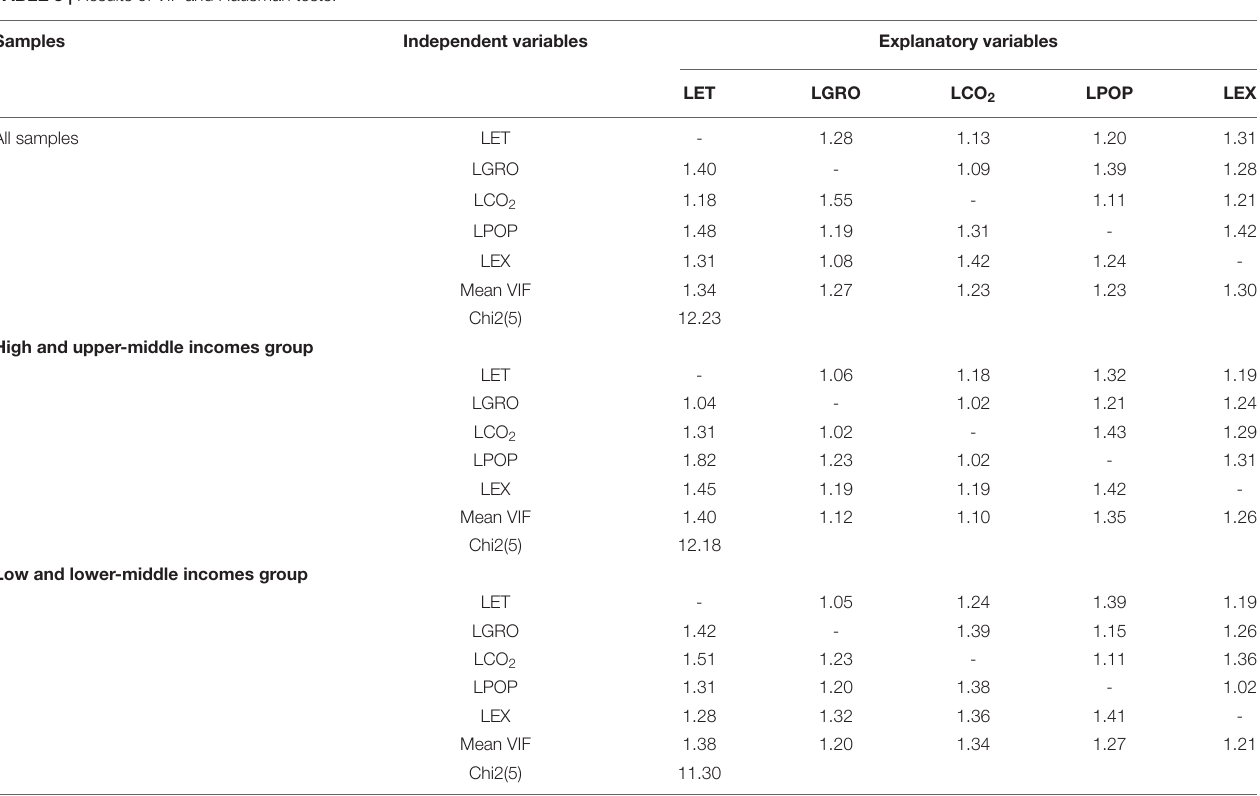
TABLE 3 | Results of VIF and Hausman tests.